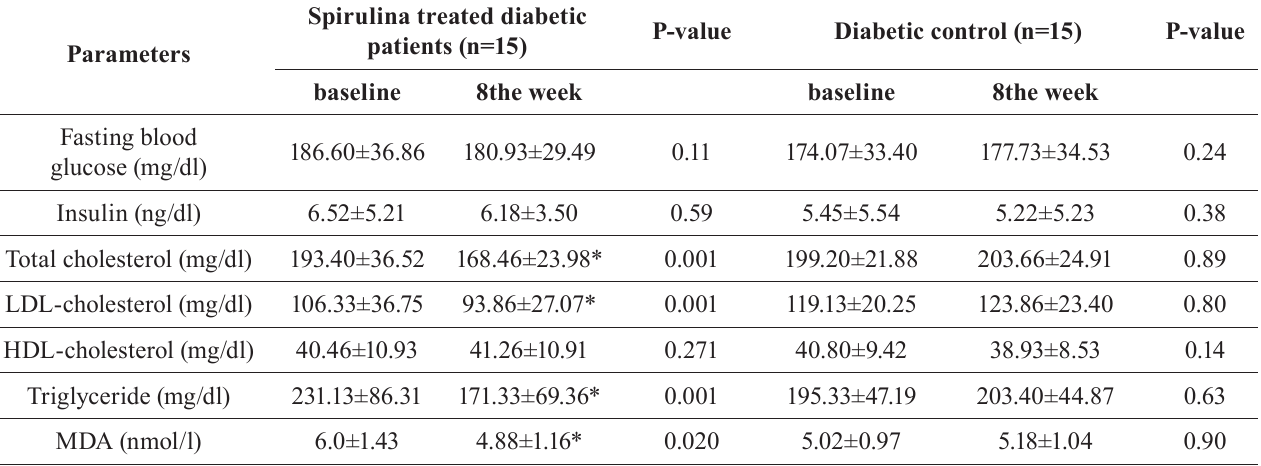
TABLE III - Blood profile of the study subjects after eight weeks intervention